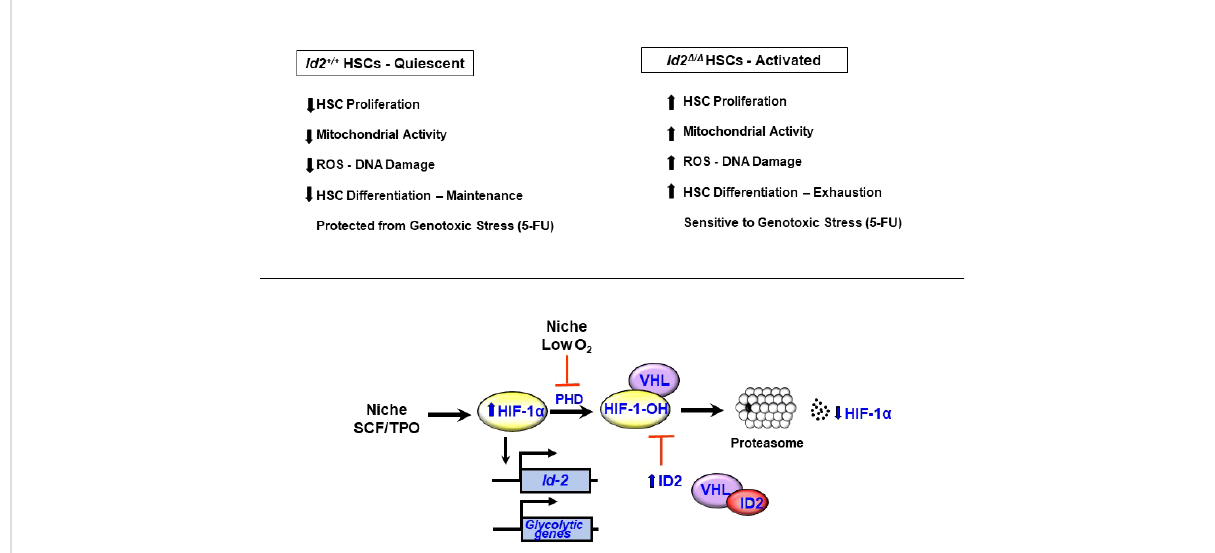
FIGURE 2 Id2 is required for HSC quiescence and maintenance. Summary of hematopoietic phenotypes in Id2 ablated mice. Hif-1 a expression is induced in HSCs by stem cell factor (SCF) and thombopoietin (TPO). HIF-1 a protein levels are maintained at low levels under normoxic conditions via the action of proline hydroxylases (PHDs), which hydroxylate HIF-1 a and promotes its association with the VHL complex, ubiquitination and proteasomal degradation. Under low O 2 conditions, PHD is inhibited resulting in reduced levels of hydroxylated HIF-1 a , and reduced ubiquitination and stabilization of HIF-1 a . ID2 also acts to stabilize HIF-1 a by binding to VHL, which prevents ubiquination and proteosomal degradation of HIF-1 a and promotes HSC quiescence.